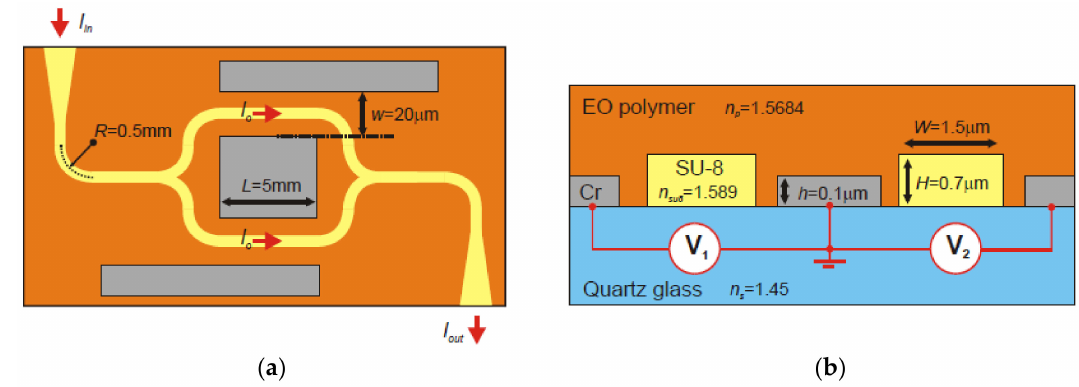
Figure 18. Dimensional parameters of the designed electro-optic modulator and its ( a ) top view; and ( b ) side view